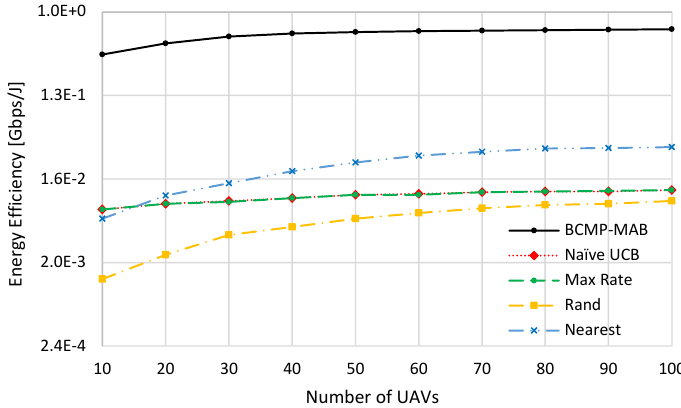
Figure 6. Average energy efficiency against number of